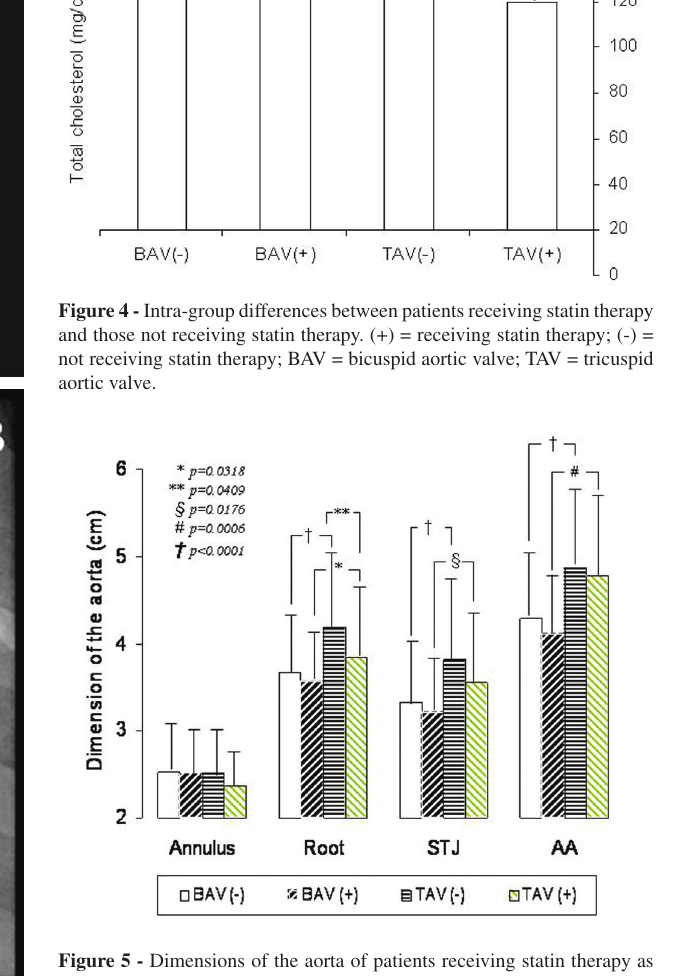
Figure 5 - Dimensions of the aorta of patients receiving statin therapy as compared to those not receiving statin therapy. (+) = receiving statin therapy; (-) = not receiving statin therapy; AA=ascending aorta; BAV=bicuspid aortic valve; STJ=sinotubular junction; TAV=tricuspid aortic